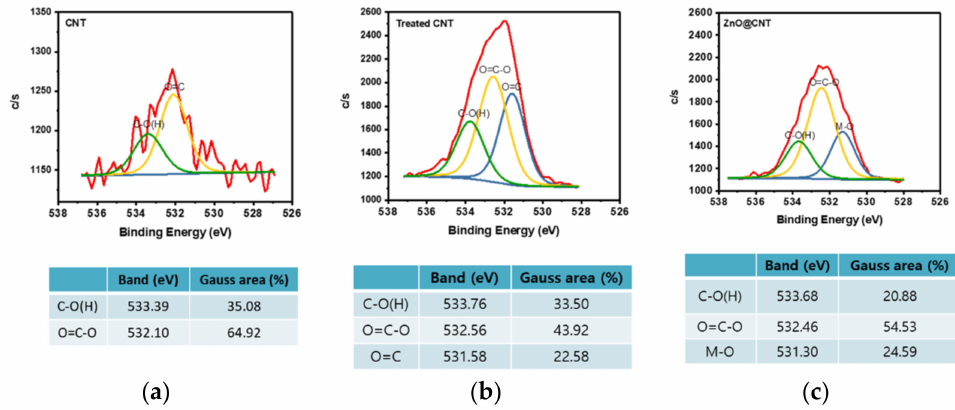
Figure 3. The XPS O 1 s spectra: ( a ) CNT; ( b ) t-CNT; ( c )